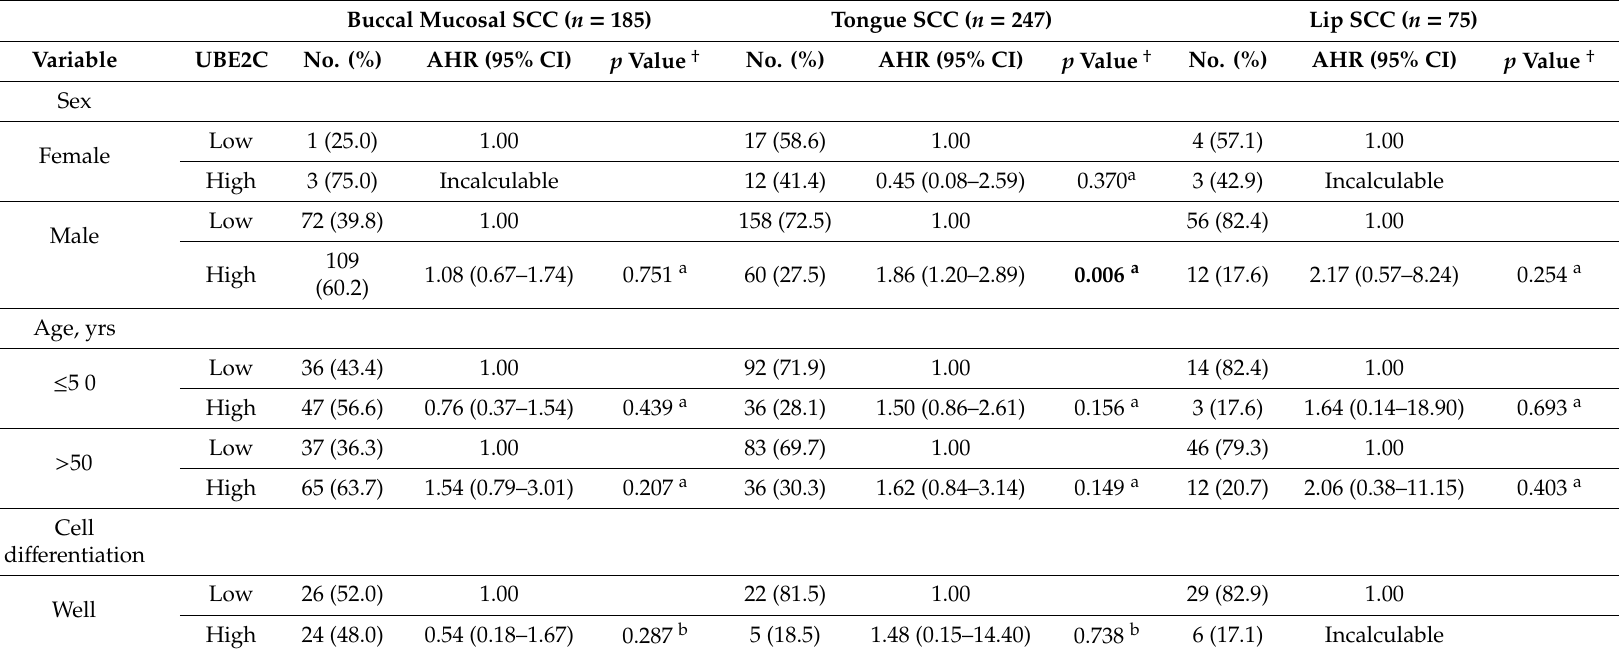
Table 2. Association of UBE2C expression with disease-specific survival stratified by clinicopathologic factors in three primary subsites of OSCC patients. Buccal Mucosal SCC ( n = 185) Tongue SCC ( n = 247) Lip SCC ( n =